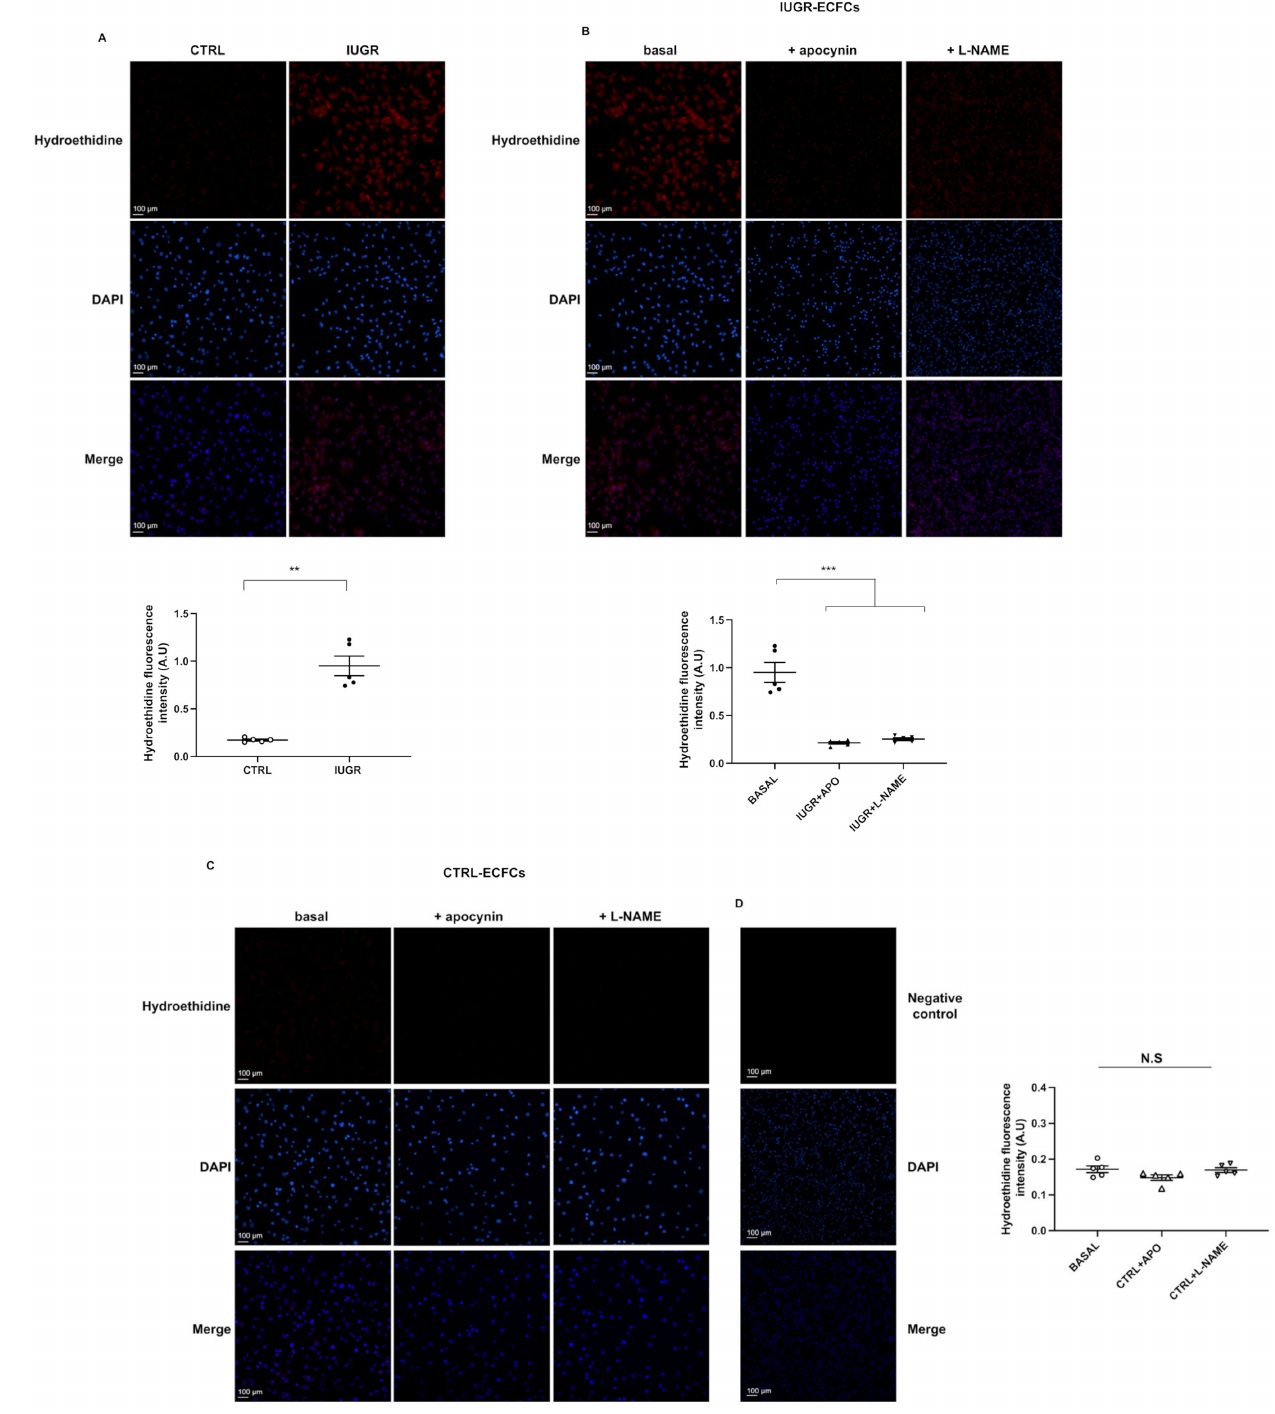
Figure 8. Superoxide anion production in ECFCs. The superoxide anion level was evaluated by hydroethidine in CTRL- ECFCs and IUGR-ECFCs isolated from six-month-old male rats under baseline conditions ( A ) and after 24 h pre-incubation with L-NAME (100 µ M) and apocynin (APO; 1 mM) in IUGR-ECFCs ( B ) and CTRL-ECFCs ( C ). Magnification (20 × ). Nuclei were counterstained with DAPI, and a test of autofluorescence was performed ( D ). These pictures are representative images from n = 5 animals/group. ** p < 0.01; *** p < 0.001; N.S: not significant. Scale bar = 100 µ